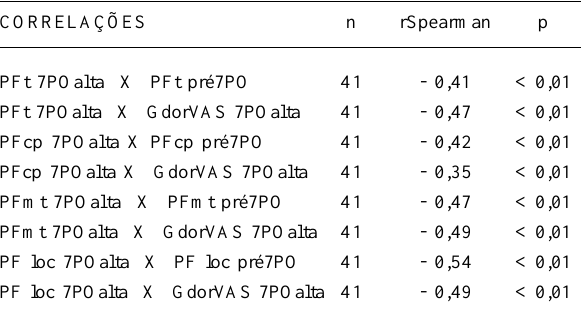
Tabela 5. Correlações entre perda funcional porcentual total e gradiente porcentual de acréscimo do nível de dor na escala